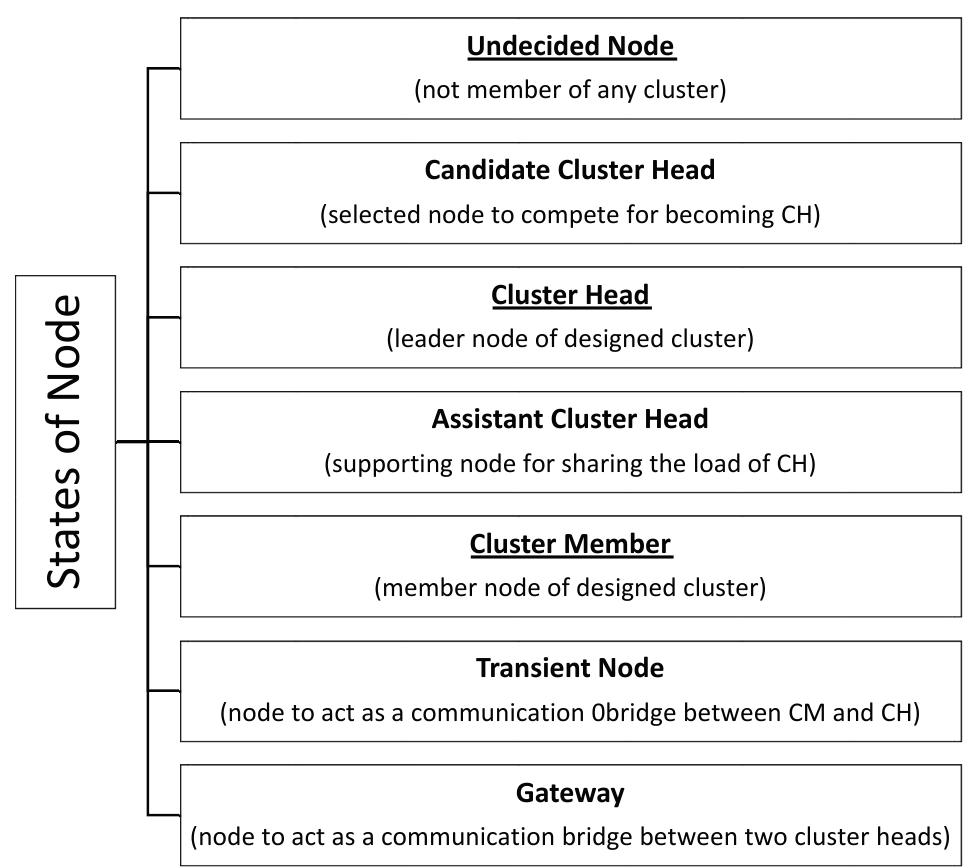
Figure 1. The various roles of nodes during their lifetime in a clustered network